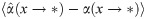
Accuracy of the inference on sampling frequency.Two interacting ants are simulated according to the same model as in Fig 5 for t ∈ [0, 10 000]. The numerical integration of the dynamical equations uses an adaptive time step with a mean 〈Δt〉 = 0.0795. The data are re-sampled by taking every k-th datapoint, for the purpose of error sensitivity analysis. The error is defined as the mean difference between the real and inferred coefficient, 〈α^(x→*)-α(x→*)〉 (analogous for β). The average is taken only for z, dz ∈ [−2, 2], where enough data are available. (region of no regularization). (A) Error in coefficients α and β inferred from the simulation in t ∈ [0, 10 000] and different sampling rates, 〈Δt〉 = 0.0795k. (B) Error in coefficients α and β inferred from the simulation in t ∈ [0, 10 000k] and different sampling rates, 〈Δt〉 = 0.0795k.